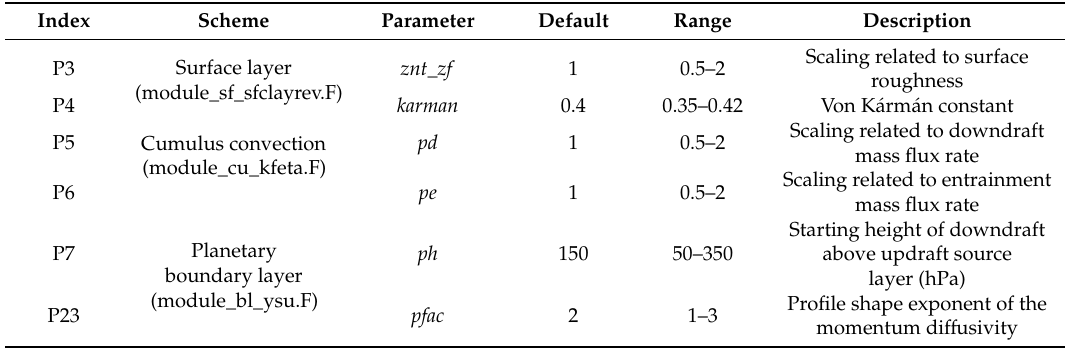
Table 2. List of sensitivity parameters for typhoon precipitation and 10-m wind simulations of WRF model version 3.7.1.